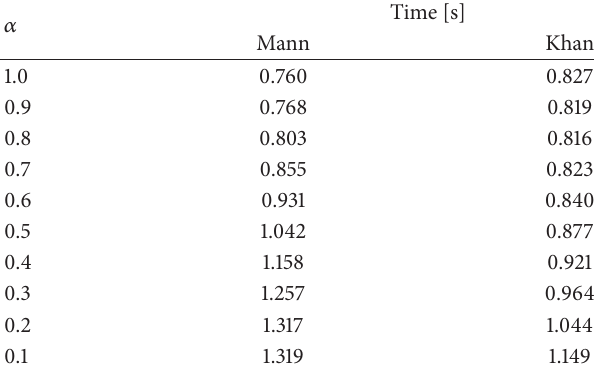
Table 2: Times of polynomiograph’s generation for 𝑝 1 using one parameter iterations.